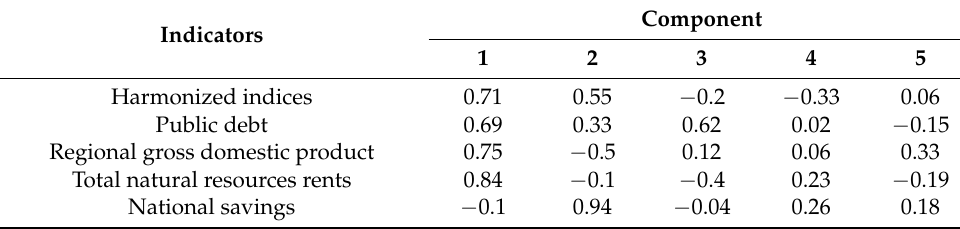
Table A5. PCAanalysis forthe macroeconomic stability pillar. All initialindicators: correlation